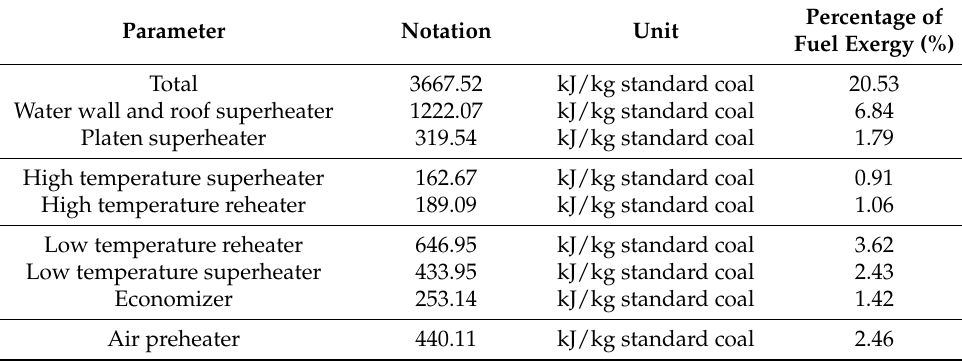
Table 8. Distribution of heat transfer exergy loss of boiler under BMCR